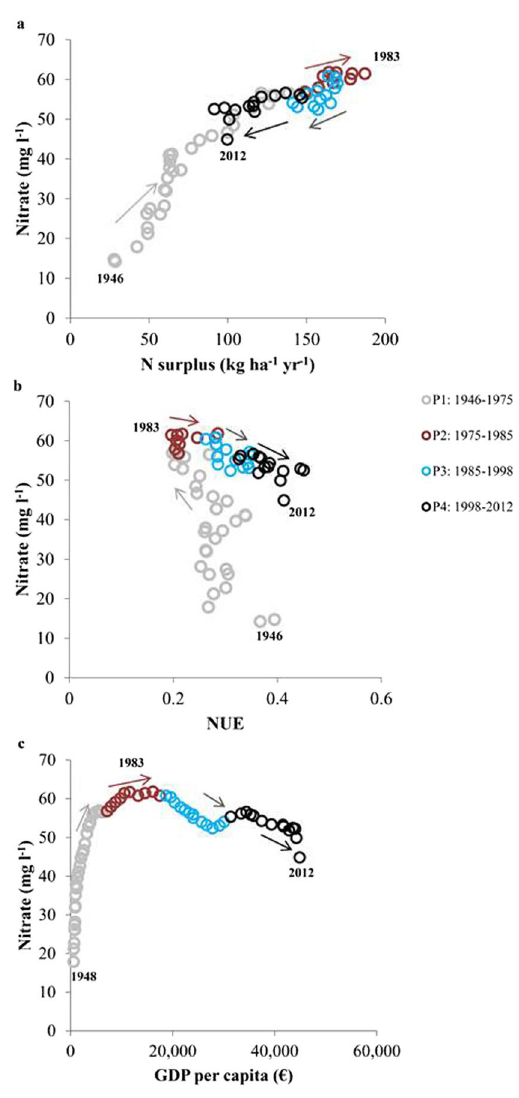
Figure 6. Nitrate trend reversals in oxic groundwater in the four groundwater infiltration periods. a, Annual N surplus in Danish agriculture. b, Annual N use efficiency (NUE) in Danish agriculture. c, Annual Danish gross domestic product per capita (GDP per capita, current prices) in euro